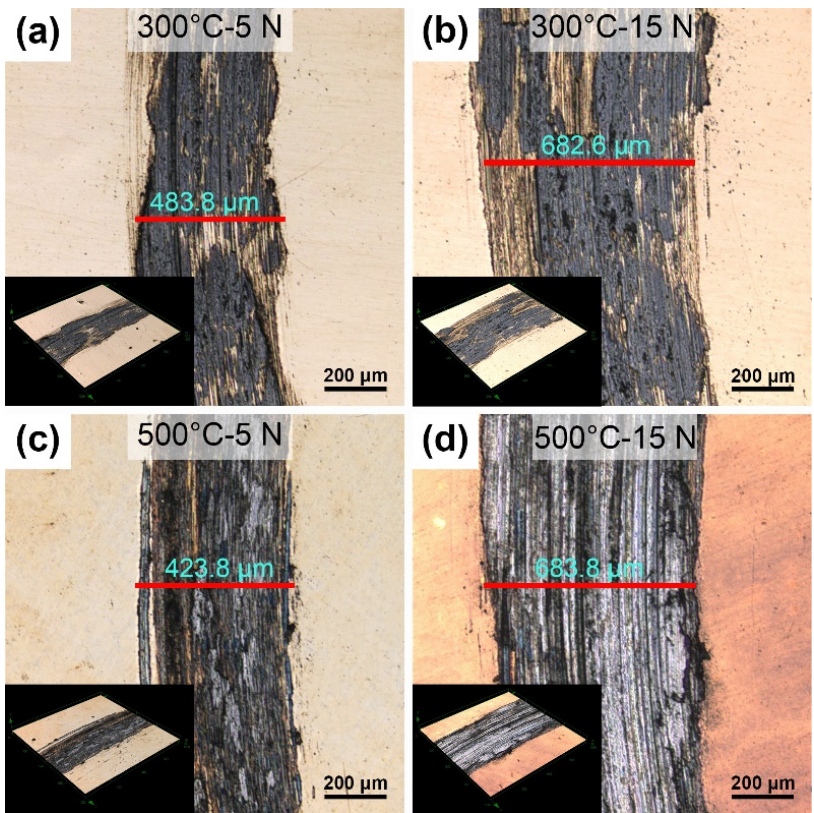
Figure 3. Morphologies of wear tracks for the HNSS under different conditions: ( a ) 300 °C–5 N, ( b ) 300 °C–15 N, ( c ) 500 °C–5 N, and ( d ) 500 °C–15 N.